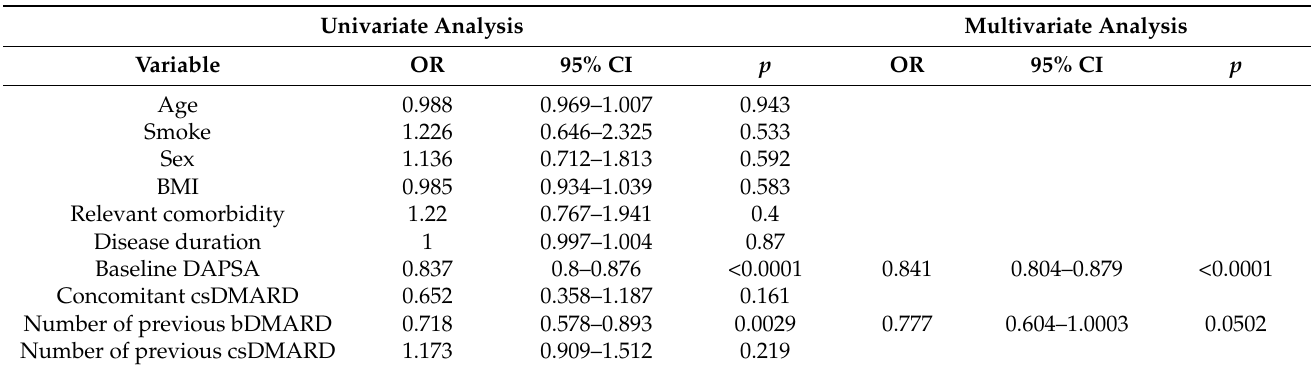
Table 3. Univariate and multivariate analysis of variables associated with achievement of DAPSA low disease activity and remission at 12 months. Univariate Analysis Multivariate Analysis